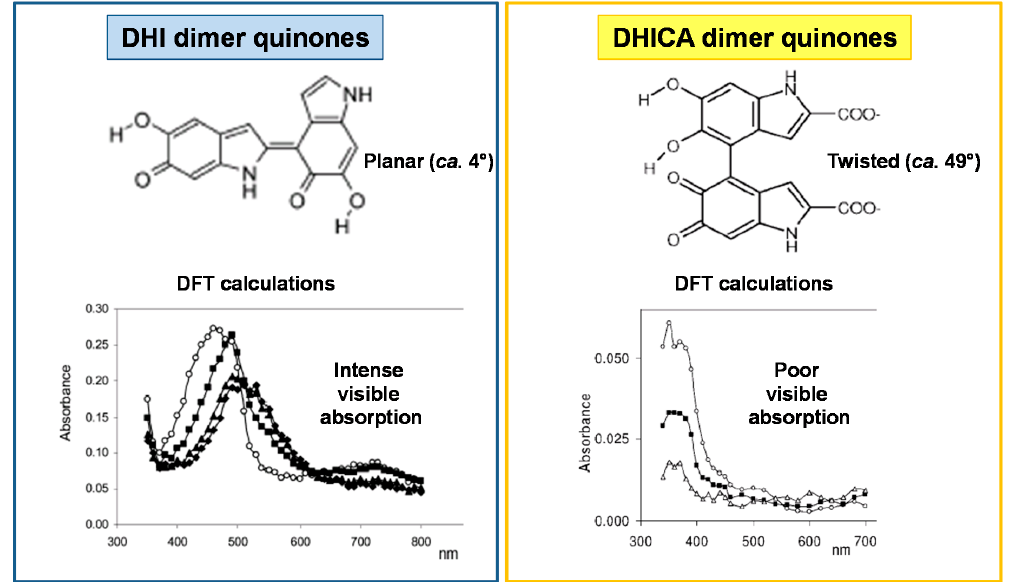
Figure 2. Predicted structures and experimental UV-visible absorption spectra at various times of the oxidation mixtures of DHI and DHICA oligomers. Blue box: change in absorption at various times after pulse radiolysis of a N 2 O-satured aqueous solution of DHI dimer (1.5 × 10 − 4 M) in 0.5 M KBr/7.0 × 10 − 2 M phosphate buffer, pH 7.0: ( ○ ) 14 μ s; ( ■ ) 102 μ s; ( ▲ ) 402 μ s; ( ♦ ) 866 μ s. Yellow box: changes in absorption at various times after pulse radiolysis of DHICA dimer (1.5 × 10 -4 M) in 0.5 M KBr/7.0 × 10 − 2 phosphate buffer, pH 7.0: ( ○ ) 400 μ s; ( ■ ) 5 μ s; ( Δ ) 44 ms [31,32].